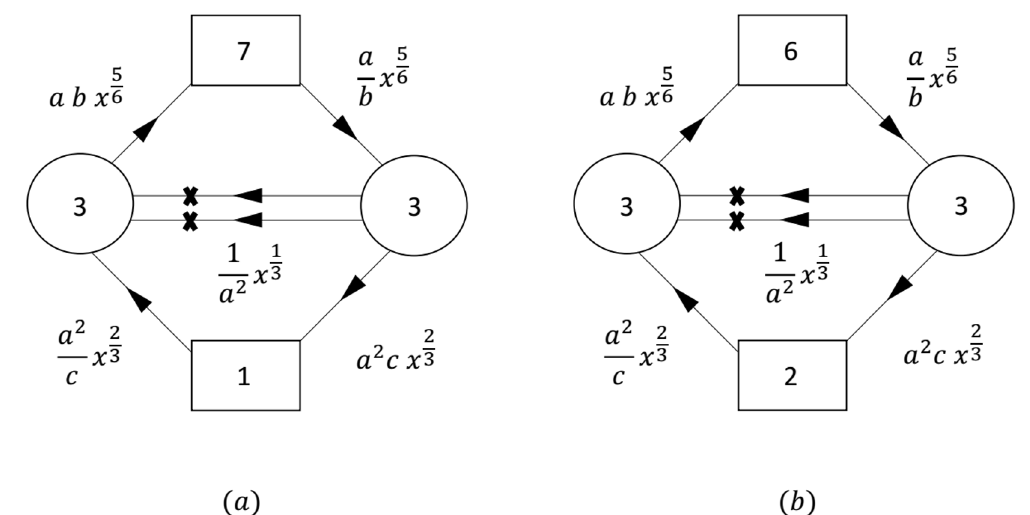
Figure 8 . Two 3 d models that are conjectured to be the compactification of the 5 d SCFTs UV completing SU(3) + 8 F gauge theories on a torus with flux. The charges of the various fields in these models under the flavor and R-symmetry U(1) groups are illustrated using fugacities. There is also a superpotential that can be read from figure 7 or alternatively as the general one consistent with all the